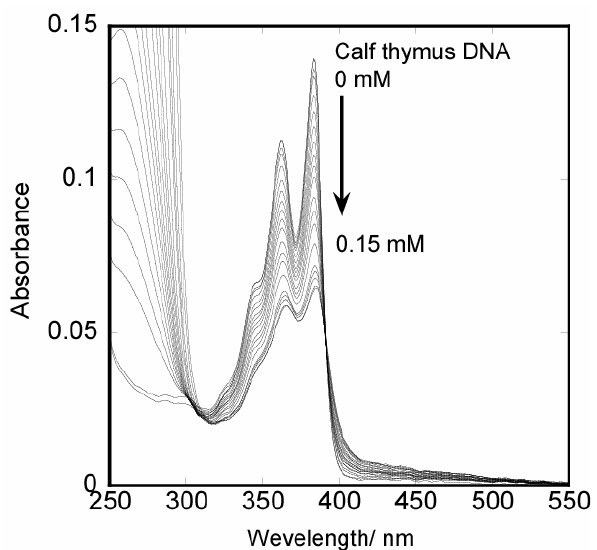
Figure 4. Spectrophotometric titration of 5 µ M 1 with 0-0.15 mM sonicated calf thymus DNA in 10 mM MES buffer (pH 6.2) containing 1 mM EDTA and 0.1 M NaCl.